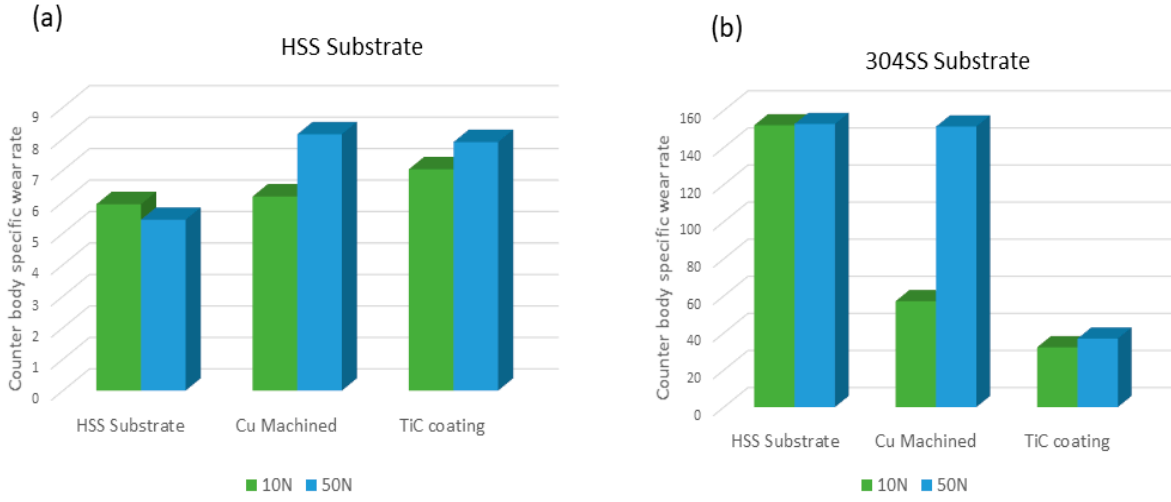
Figure 10. Wear rate of substrates of: ( a ) HSS and ( b ) 304-SS (as polished substrate; EDM Cu machined surface; and ED-coated TiC/Fe cermet) [7].